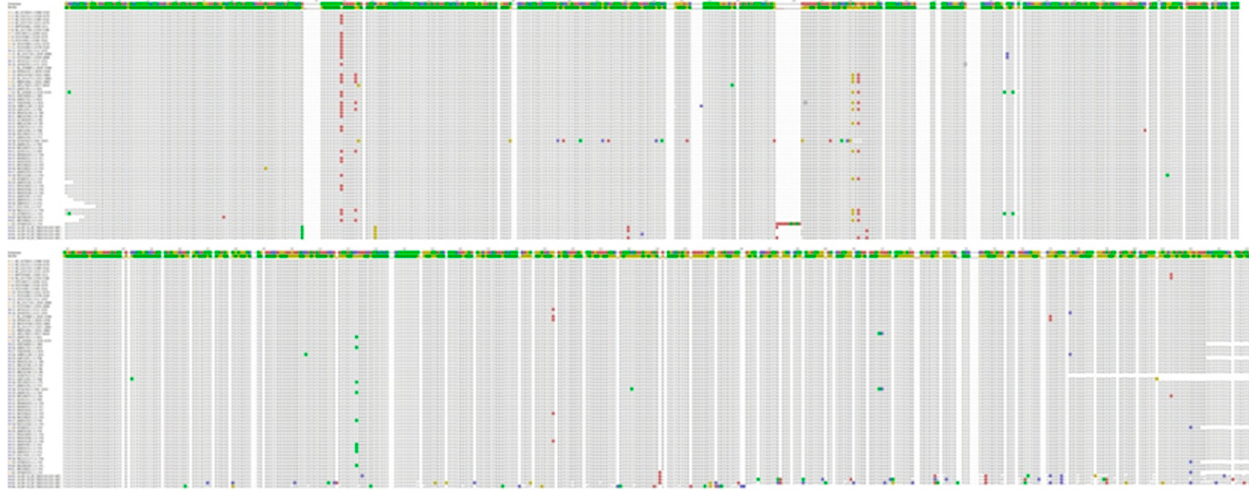
Figure 3. Multiple sequence alignment of the matK XF + 5R region of U. vilosa from Pakistan. Different colors indicate the SNPs within the matK region.